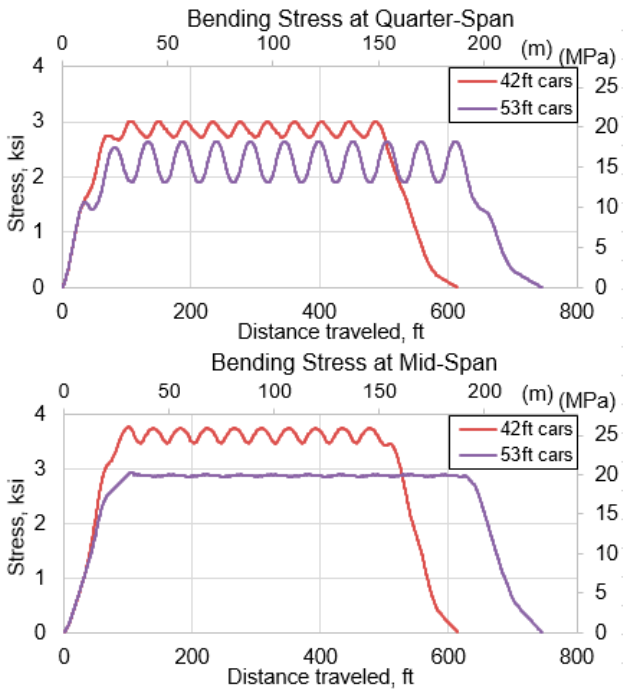
Figure 18. FEM stress histories for 35 ‐ m (115 ‐ ft) girder of DPG span.